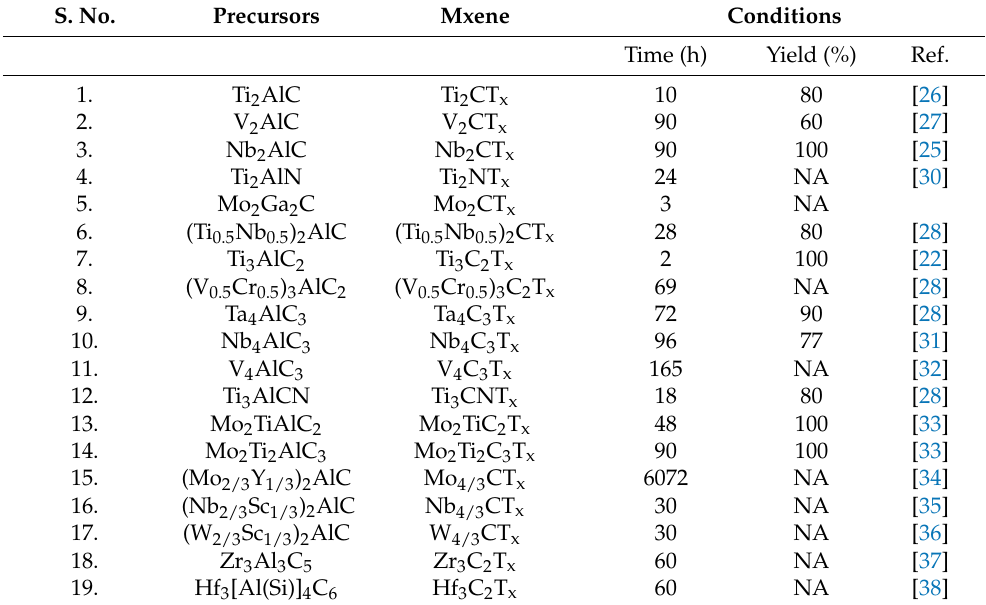
Table 2. Summary of MXenes prepared by HF treatment. Etchant used—HF (10% to 51%).